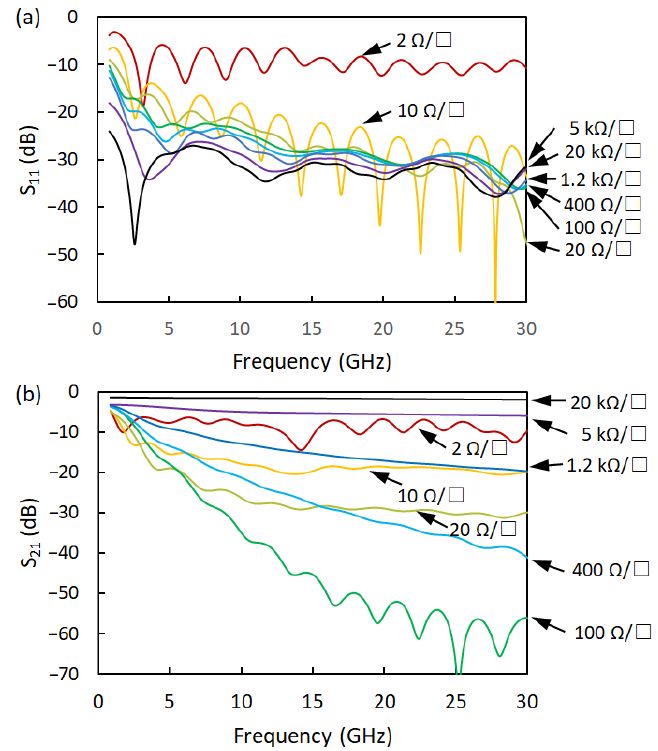
Figure 5. The S-parameters of the terminations as a function of the sheet resistance of rGO at double-end configurations, ( a ) reflections |S11|, and ( b ) transmissions |S21|.